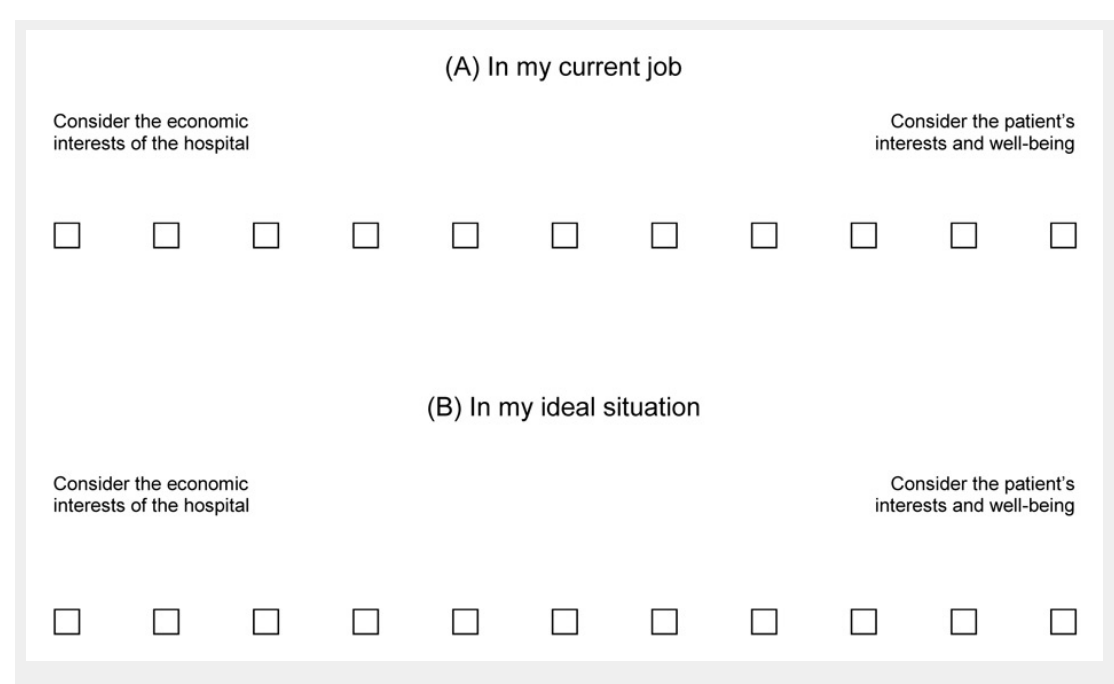
Patient interest vs economic considerations. Various considerations play a role in the decisions you make during your everyday clinical work. On one hand you strive to achieve the best possible medical outcome for your patients and, on the other, you try to consider the economic interests of your department. Please estimate the relative weight of your